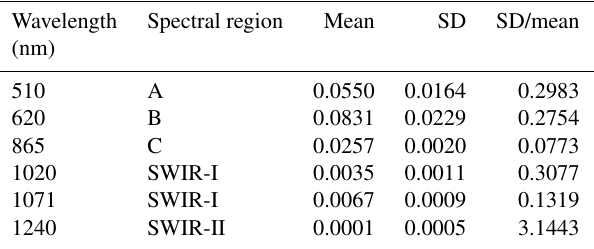
Figure 6. Water reflectance spectra with a TSM concentration of ∼ 100mgL − 1 for the Scheldt ( n = 4), Río de la Plata ( n = 4) and Gironde ( n = 2) estuaries. The average of all spectra is shown as a black solid line. The average minus and plus the standard deviation is shown in dashed black line. The pure water absorption coefficient (Pope and Fry, 1997; Kou et al., 1993) is shown in light grey. Table 3. Statistics for the ASD reflectance for the reflectance spec- tra shown in Fig. 6 with a TSM concentration of ∼ 100mgL − 1